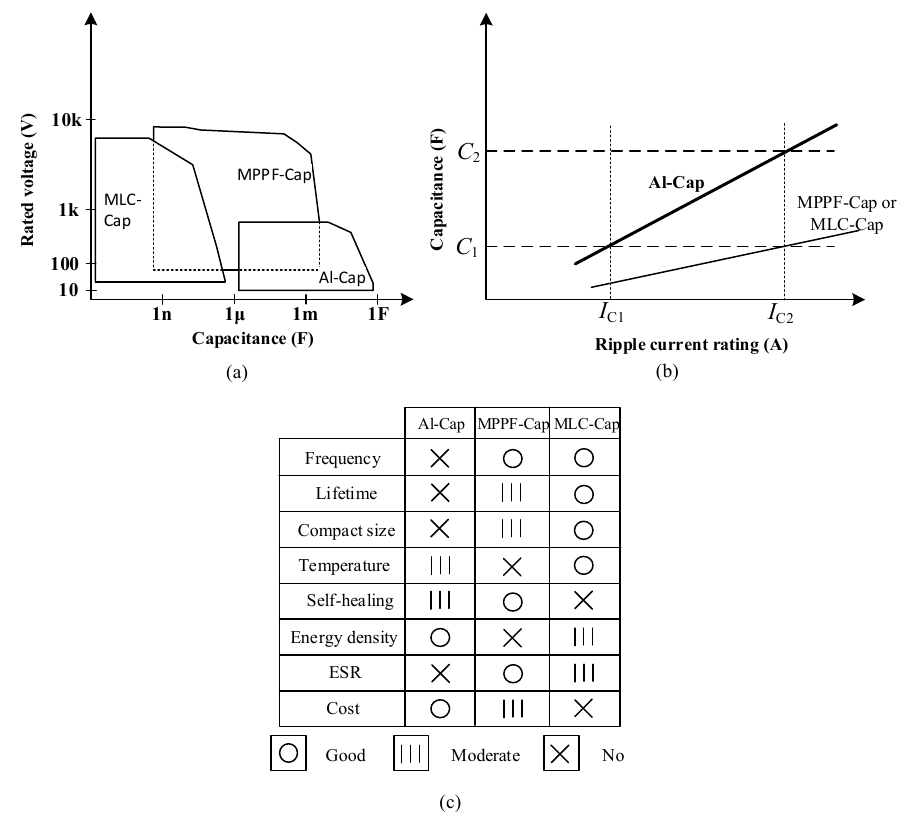
Figure 4. Comparisons of the three types of capacitors: ( a ) voltage range versus capacitance value; ( b ) required capacitance with respect to ripple current; ( c ) comparison based on various other parameters.